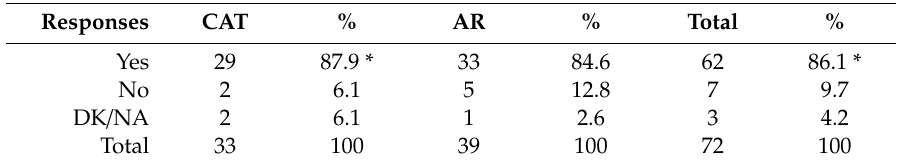
Table 6. Answers obtained in Q4 (source: